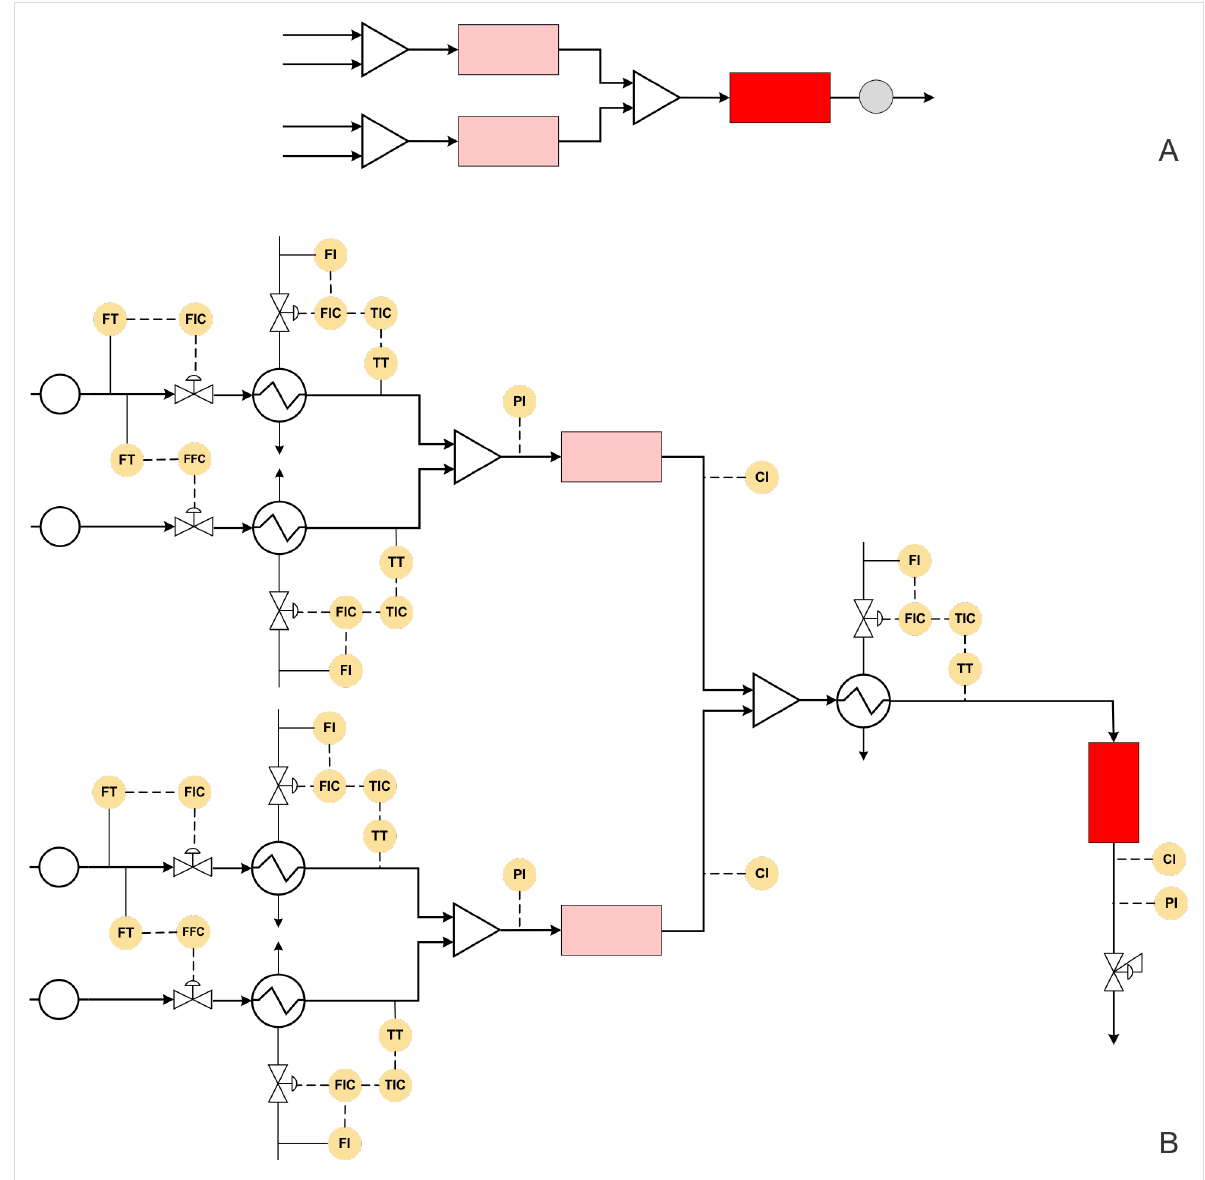
Figure 5: (A) Block diagram representation of the process shown in Scheme 3, (B) piping and instrumentation diagram of Scheme 3.